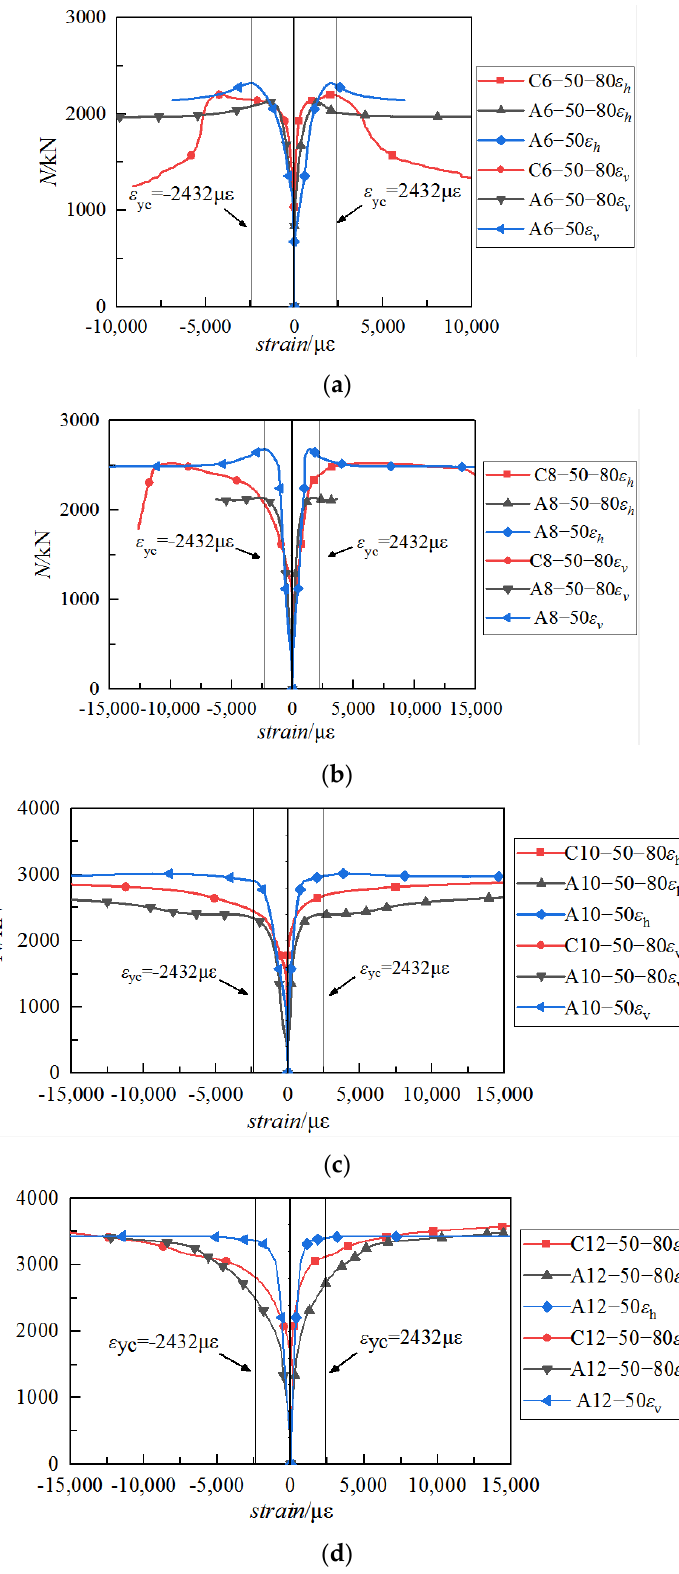
Figure 14. N and the middle section strain. ( a ) D o / t o = 28, ( b ) D o / t o = 21, ( c ) D o / t o = 17, and ( d ) D o / t o = 14 .